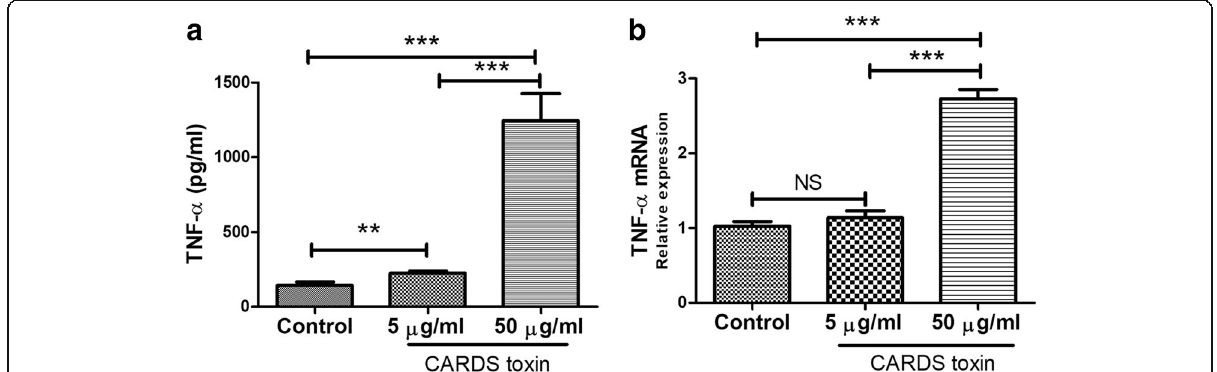
Fig. 5 CARDS toxin induced RAW264.7 macrophages to secrete TNF- α . RAW264.7 macrophages were co-cultured with different concentrations of CARDS toxin (0, 5, and 50 μ g/mL) for 48 h. a TNF- α level secreted from RAW264.7 cells was determined by ELISA. b TNF- α mRNA level in